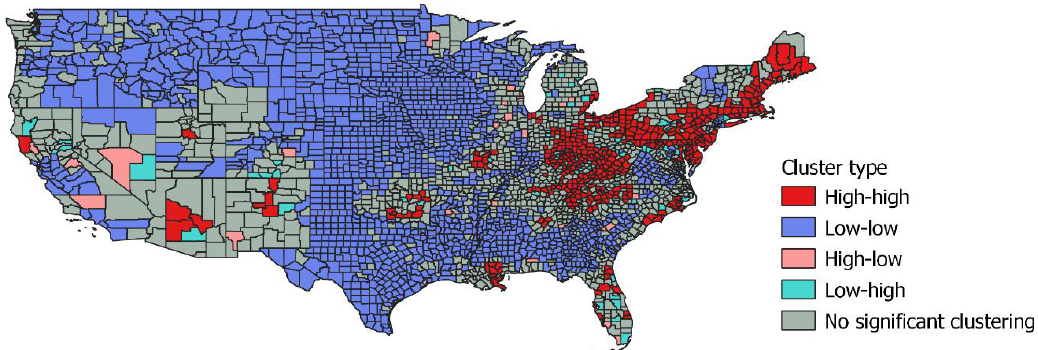
Figure 1. Continental USA. Drug-related mortality 2015–2017, cluster types. Table 2. Distribution of Risk and Risk Cluster Status across US States.